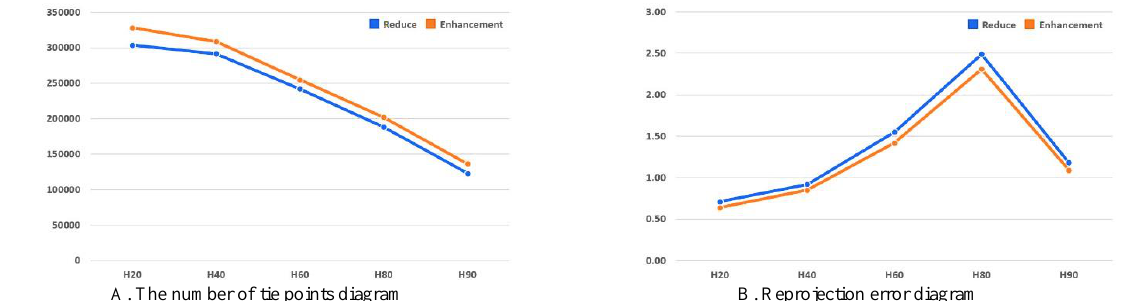
Figure 7 . At different flying altitudes and in low contrast and enhanced modes, the number of tie points and reprojection error is shown in a